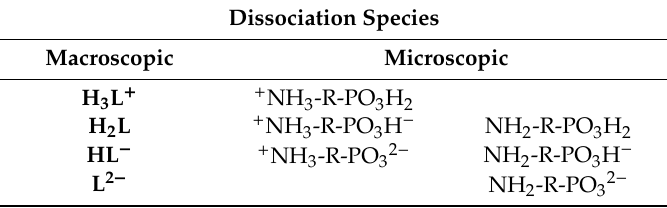
Table 5. Macroscopic and microscopic dissociation species of aminophosphonic